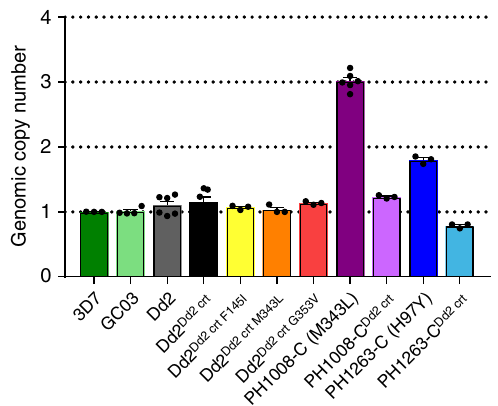
Fig. 6 p fpm2 ampli fi cation is not essential for PPQ resistance but may be associated. qPCR-based determination of pfpm2 copy number, shown as means ± SEM. Results showed the presence of only one pfpm2 copy in PPQ- resistant genetically edited Dd2 lines that expressed novel pfcrt alleles. The multiple pfpm2 copies observed in the Cambodian lines PH1008-C and PH1263-C were reduced to single copies upon removal of the PfCRT M343L or H97Y mutations. These data were consistent with the decrease in RNA expression levels observed by RT-qPCR (Supplementary Table